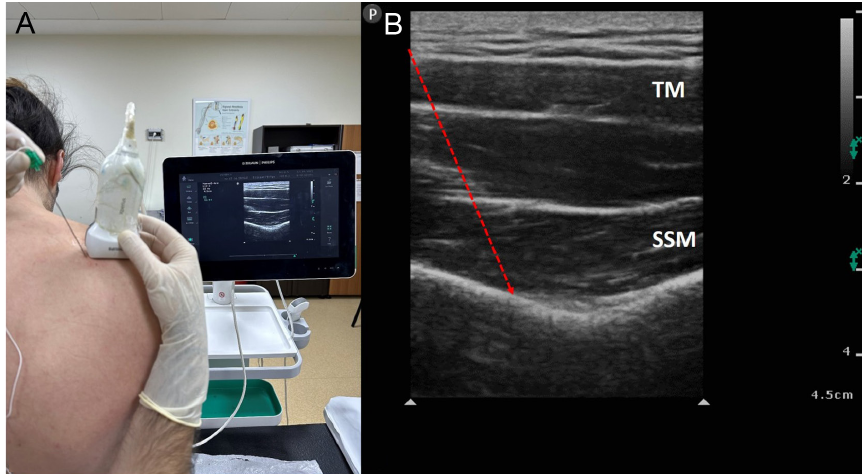
Figure 8. A, B. (A) Patient and ultrasound probe position for deep supraspinatus muscle plane block procedure. (B) Sonographic anatomy of the block. SSM, supraspinatus muscle; TM, trapezius muscle; red arrow, needle.